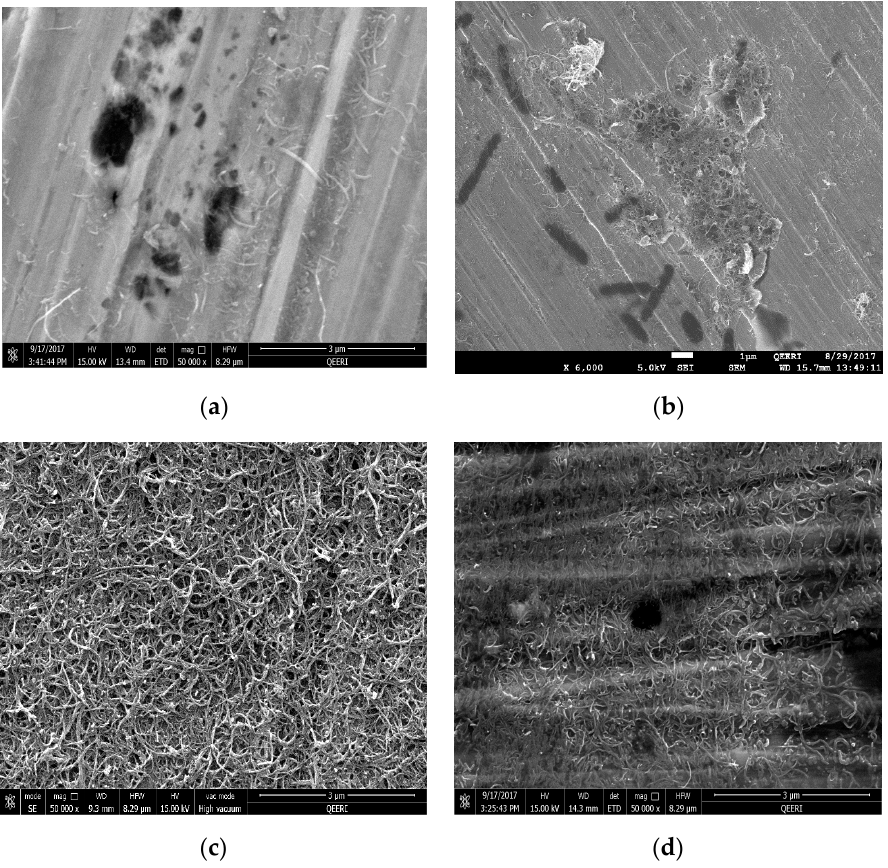
Figure 8. SEM images for 316L stainless steel samples after the potentiodynamic testing with different CNT loadings of CNT-water nanofluid, before washing with ( a ) 0.05, ( b ) 0.1, ( c ) 0.3 and ( d ) 0.5 wt%.